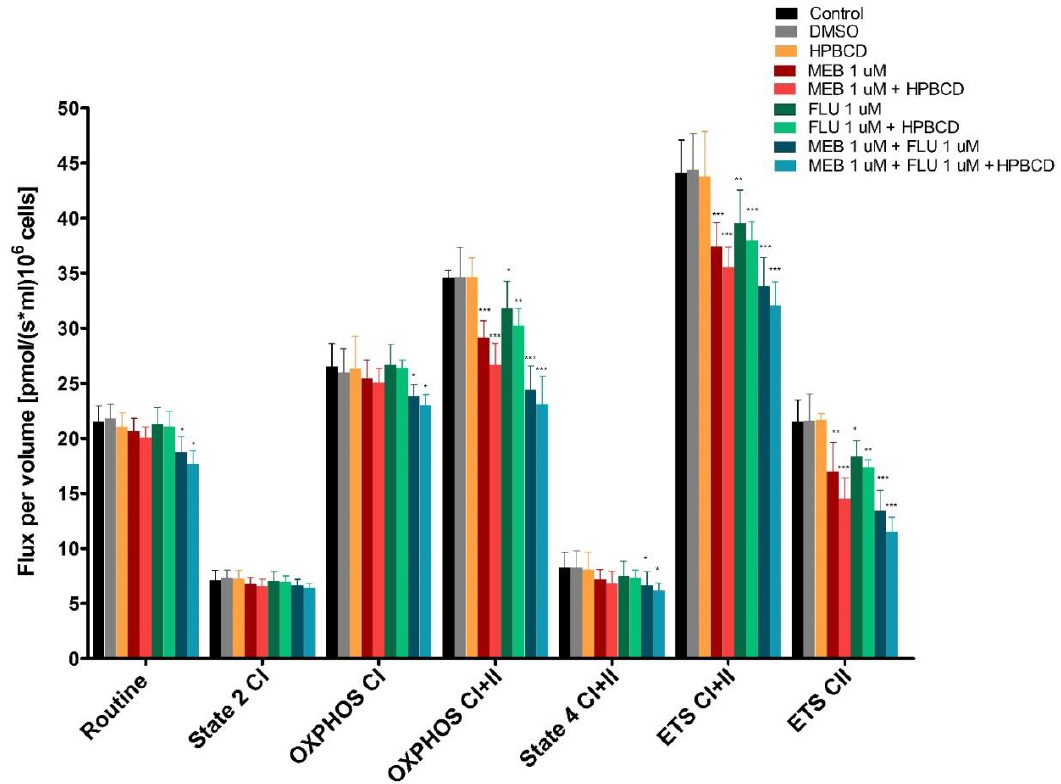
Figure 10. Mitochondrial respiration rates of permeabilized A375 human melanoma cells following 72 h of stimulation with 1 µ M of HPBCD, MEB ± HPBCD, FLU ± HPBCD, and MEB + FLU ± HPBCD. The maximum concentration of DMSO used in this study was 0.25% and did not influence the mitochondrial function. The obtained data (pmol · s − 1 mL − 1 10 − 6 cells) is presented as mean ± SD of five individual experiments. The statistical analysis was performed using two-way ANOVA, followed by Bonferroni post-test (* p < 0.05, ** p < 0.01, and *** p < 0.001).